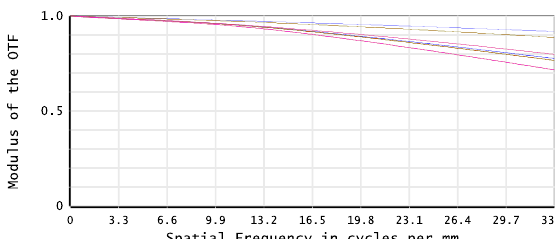
Figure 10. Resulting MTF graph of the overall HSI for 400 nm